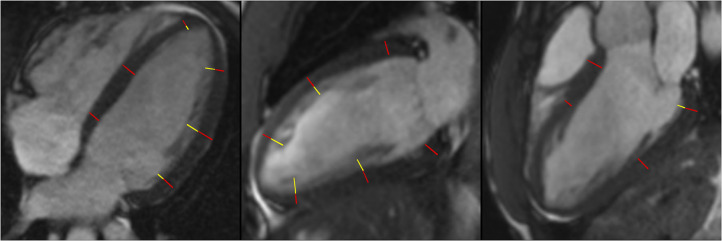
Measurement of NC/C ratios in 4-chamber, 2-chamber, and 3-chamber longitudinal view. Red lines represent compacted myocardium defined as a myocardial layer of homogeneous moderate signal intensity distinctly separate from the blood pool, yellow lines represent measurement of trabeculations defined as a meshwork of moderate signal intensity on the endocardial surface of the compacted myocardium with interspersion of higher SI from the blood pool; NC/C, non-compacted to compacted ratio. SI, signal intensity.